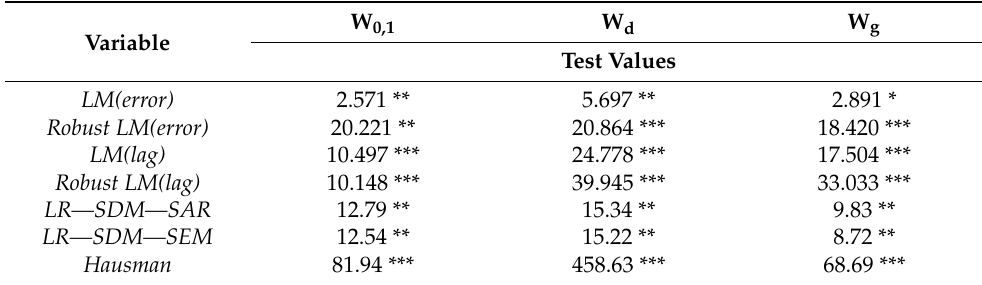
Table 4. Choice of spatial econometric